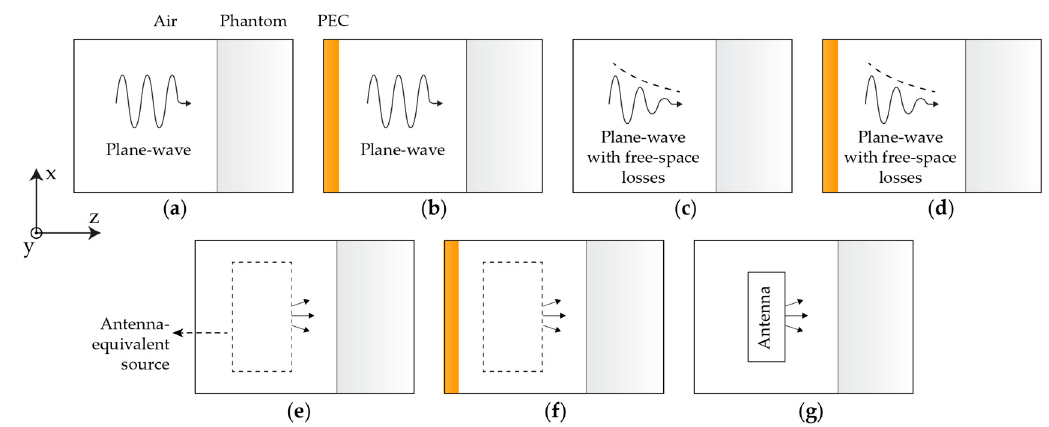
Figure 1. Schematic representation of considered exposure scenarios: ( a ) scenario 1; ( b ) scenario 2; ( c ) scenario 3; ( d ) scenario 4; ( e ) scenario 5; ( f ) scenario 6; ( g ) scenario 7. PEC: perfect electric conductor.